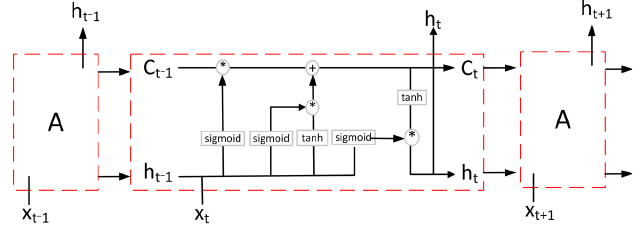
Figure 3. Expanded LSTM in time sequence.